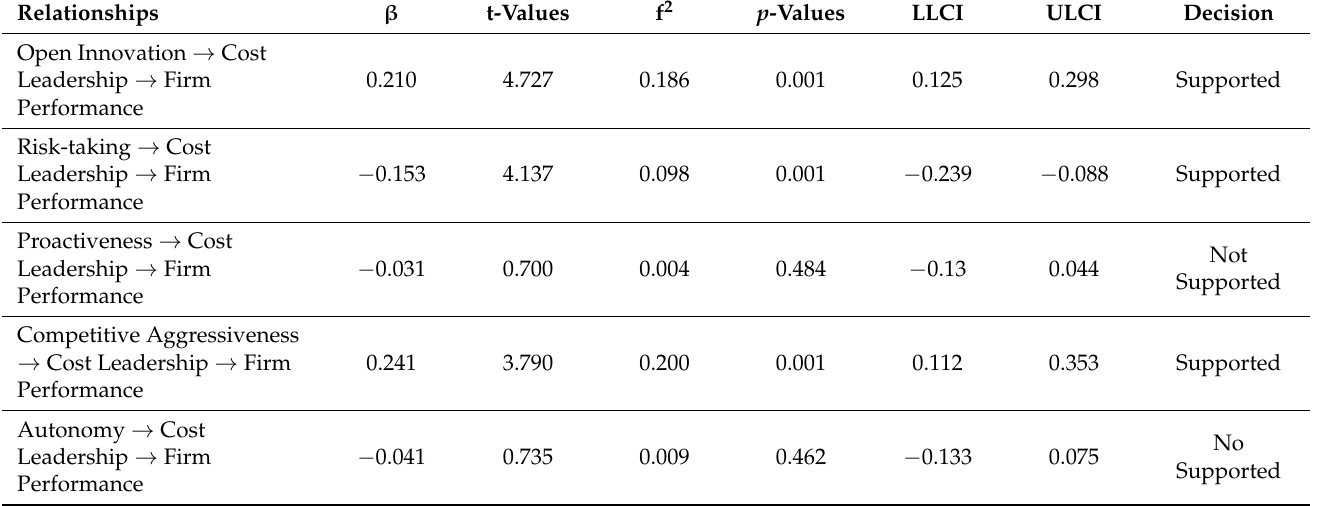
Table 7. Mediation analysis.